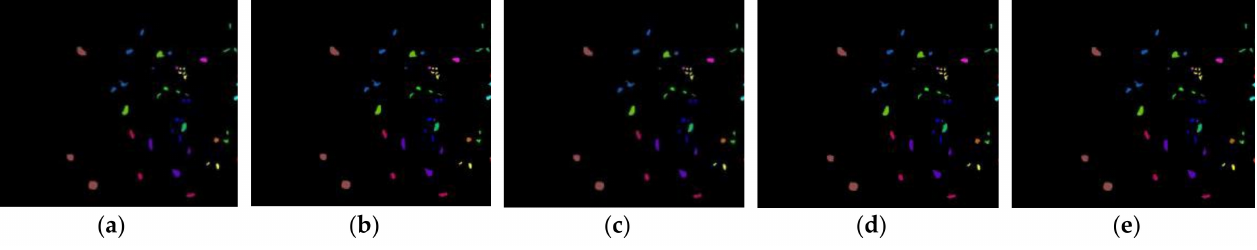
Figure 11. Kennedy Space Center hyperspectral image classification result image. ( a ) (ground truth), ( b ) SVM, ( c ) TWSVM, ( d ) AENSVM, ( e )